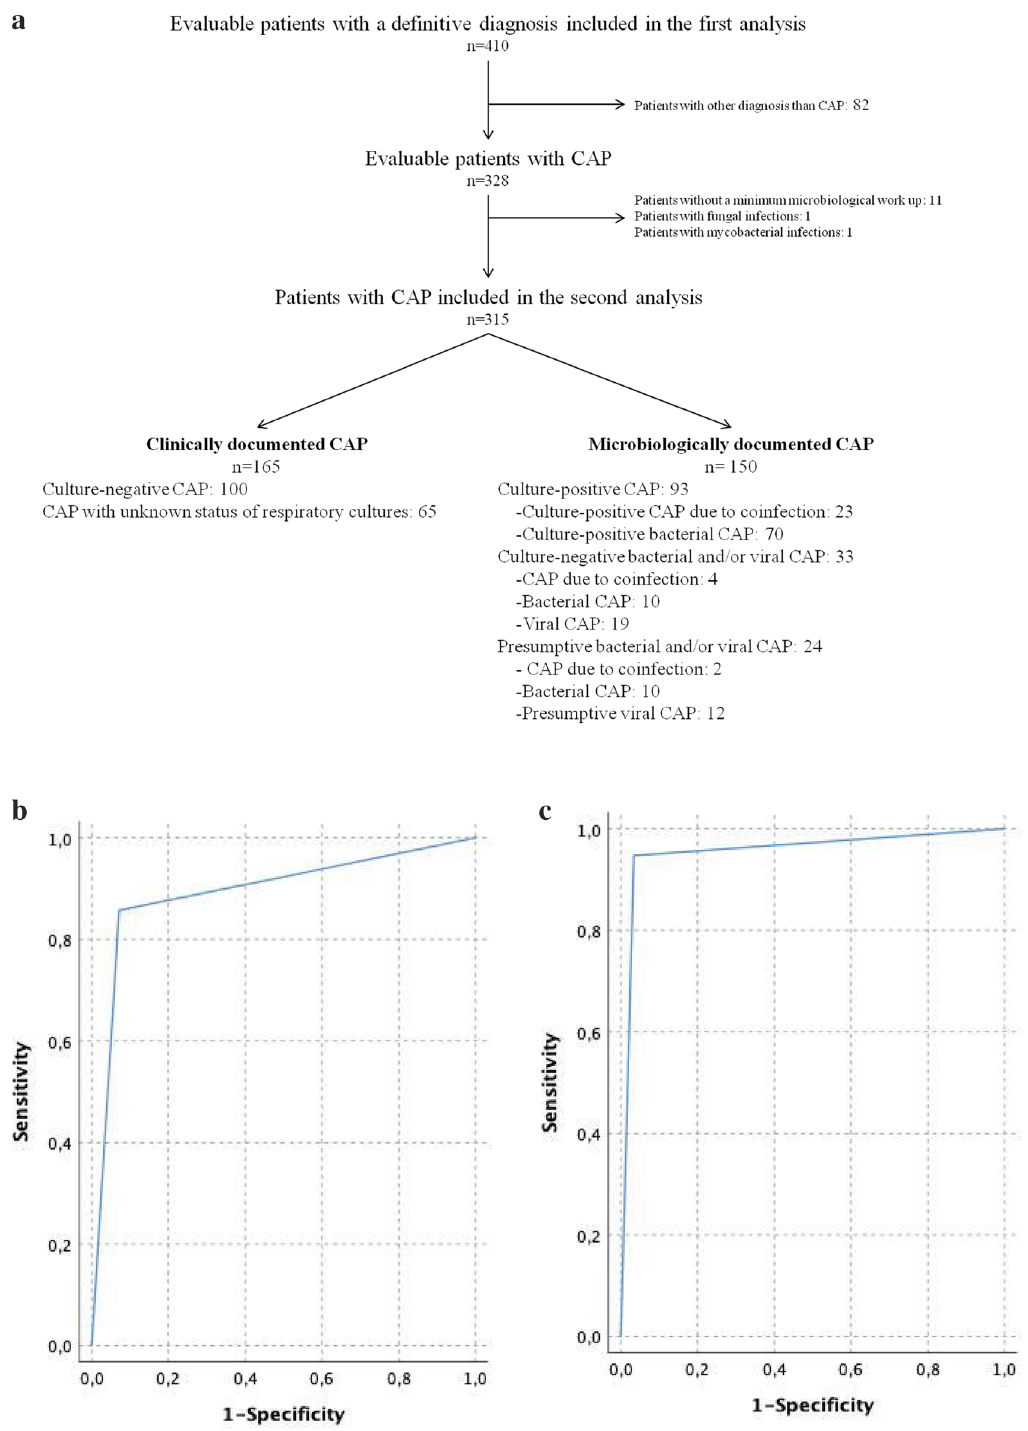
Figure 2. ( a ) Flow chart of patient enrollment and determination of the etiologies of community-acquired pneumonia. CAP community-acquired pneumonia, LUS lung ultrasound. Please see Supplement for discursive definitions of each cohort. ( b ) Receiver operating characteristic curve for predicting CAP caused by bacteria (all bacterial CAP vs viral CAP) by lung ultrasound. The area under the receiver operating characteristic curve = 0.89 (95% CI, 0.82%-0.97%). ( c ) Receiver operating characteristic curve for predicting bacterial coinfection among patients with CAP caused by viruses (CAP due to coinfection vs viral CAP) by lung ultrasound. Area under the receiver operating characteristic curve = 0.95 (95% CI,